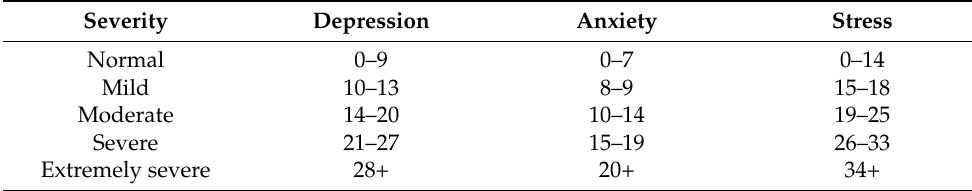
Table 1. Cut-off points for Depression Anxiety Stress Scale (DASS